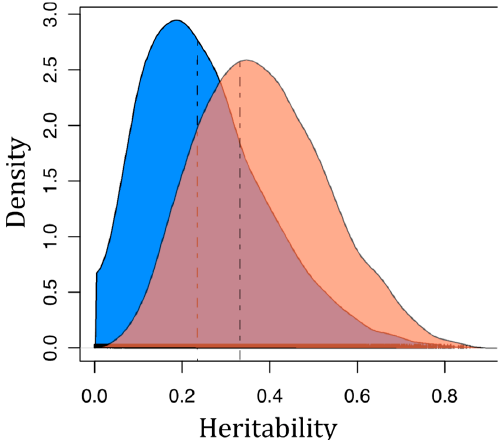
Figure 6. Posterior distributions of the heritability estimates for LCDV susceptibility in batch 1 (red) and batch 2 (blue) generated from Bayesian MCMCglmm models. Dashed lines correspond to distribution modes.